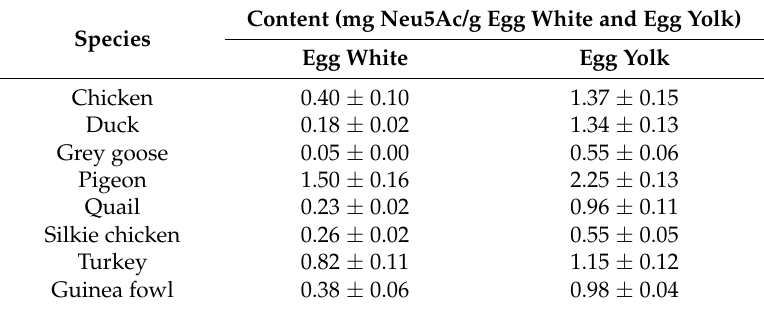
Table 2. Neu5Ac concentrations of egg white and egg yolk